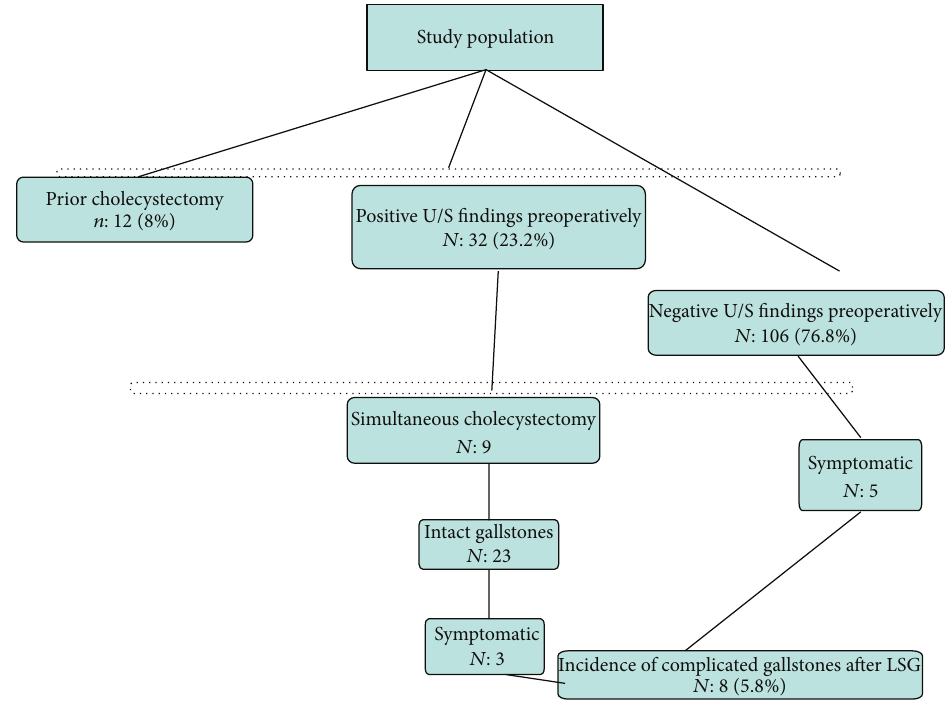
Figure 1: Incidence of complicated gallstones after